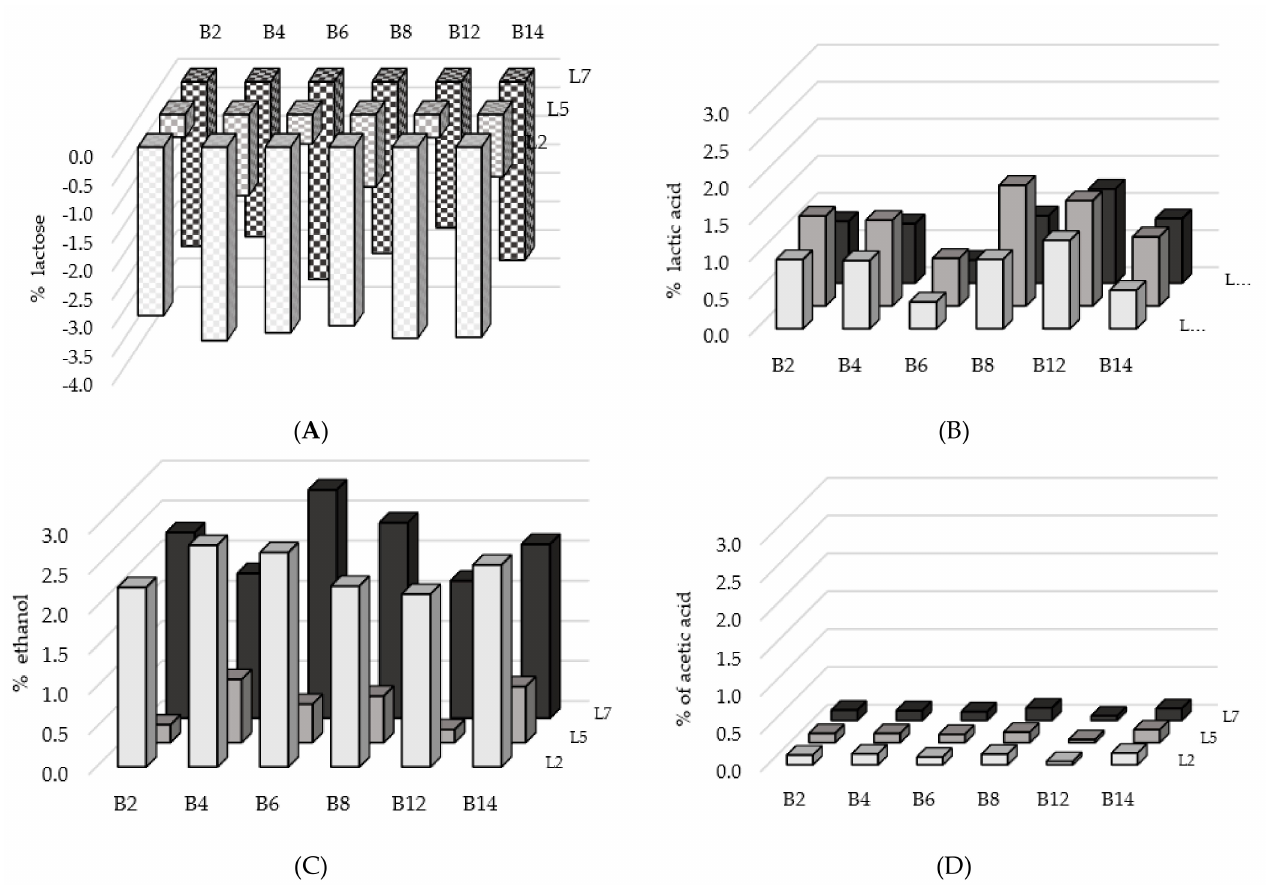
Figure 2. Reduction of lactose content ( A ), production of lactic acid ( B ), ethanol ( C ) and acetic acid ( D ) during the fermentation trials in microcosms inoculated with different pairs of LAB and yeast